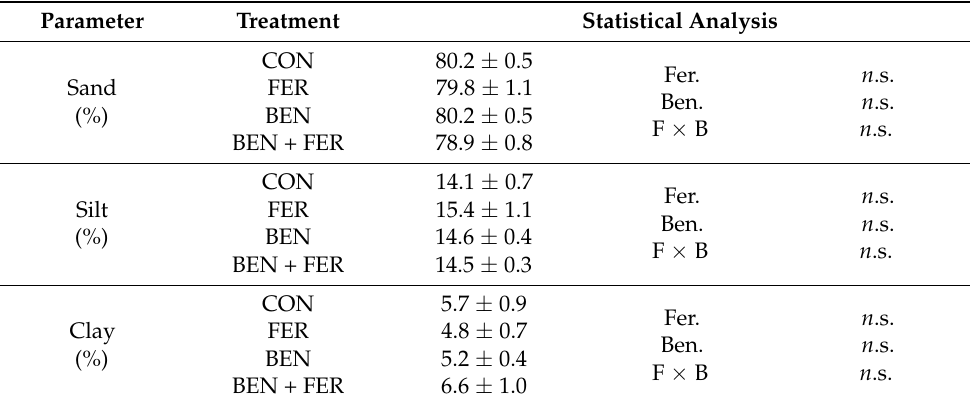
Table 1. Texture of soils in the four treatments (mean ± SE, n = 9) sampled in June 2014. There was no significant effect of fertilizer, bentonite and their interaction. Parameter Treatment Statistical